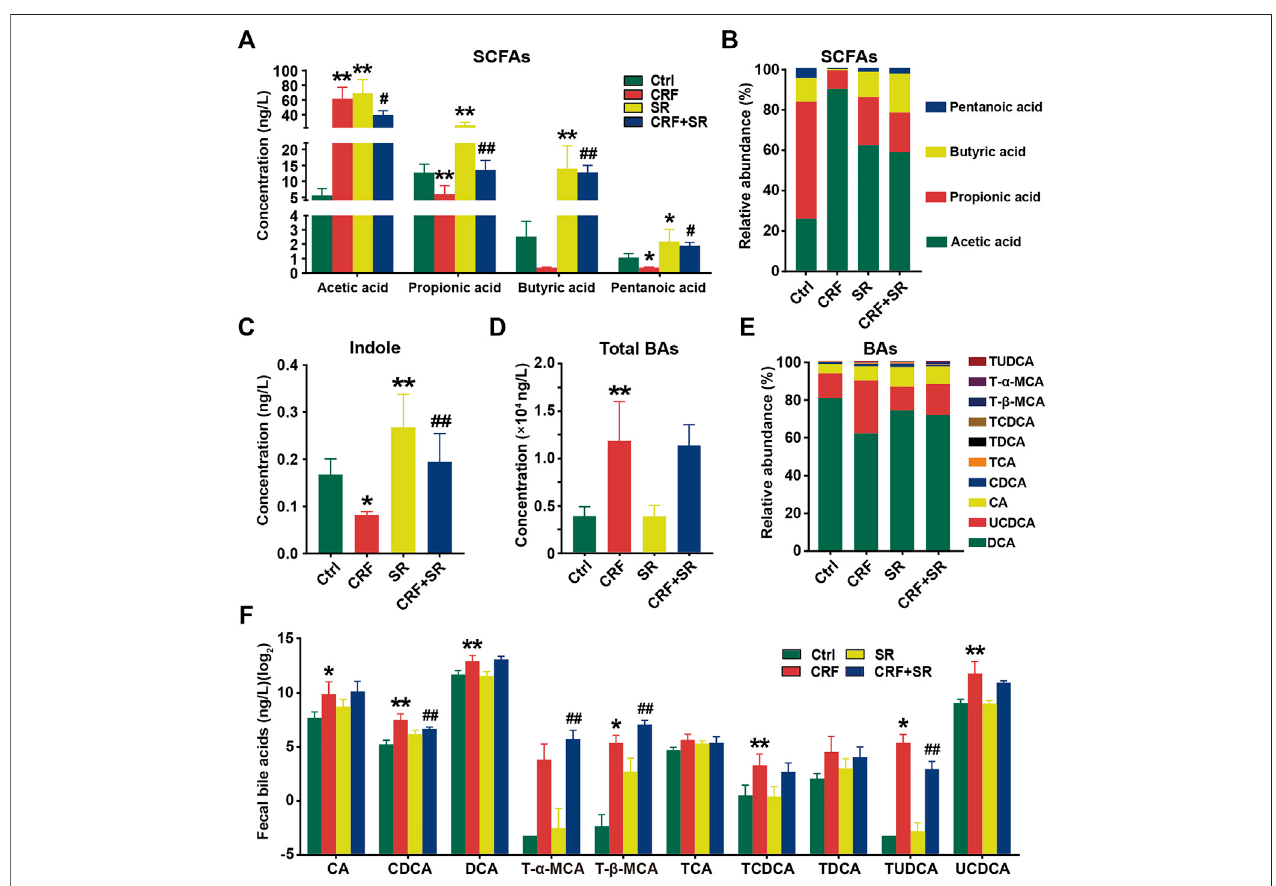
FIGURE 5 | Regulatory effect of SR decoction on production of gut microbiota metabolites in CRF mice. (A) SCFAs contents in feces. (B) Relative abundances of individual SCFAsin feces. (C) Content ofindole content in feces. (D) Contentsof total BAsin feces. (E) Relative abundances ofindividual BAs infeces. (F) Quanti fi cation of individual BAs. Data were presented as mean ± SD (n = 6). * p < 0.05, ** p < 0.01 vs. Ctrl group; # p < 0.05, ## p < 0.01 vs. CRF group.